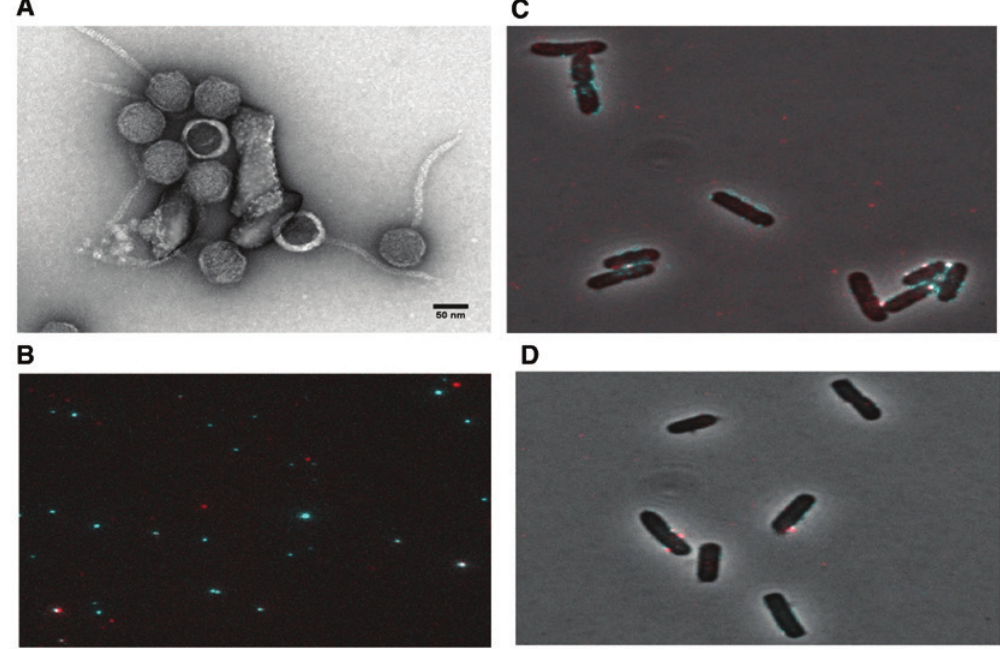
Figure 18: Fluorescent nanodiamonds-bacteriophage conjugates maintain host identification. (A) High magnification TEM images of biotinylated bacteria phages bound to streptavidin-functionalized FNDs. (B) Optical image of biotinylated bacteria phages (blue spots) bound to streptavidin-functionalized FNDs (red spots). (C and D) Optical images of biotinylated bacteria phages (blue spots) bound to streptavidin-functionalized FNDs (red spots) that have infected bacterial cells ( E. coli